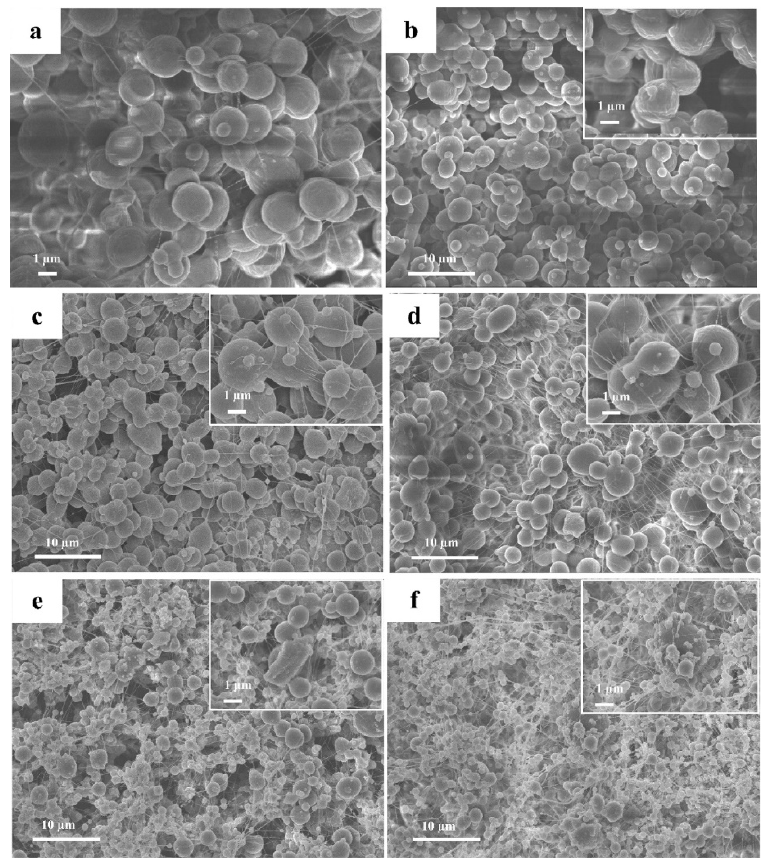
Figure 12. Morphology of the PCL/SiO 2 -the composites with different contents of SiO 2 aerogel: ( a ) PCL; ( b ) 0.1% SiO 2 aerogel; ( c ) 0.3% SiO 2 aerogel; ( d ) 0.5% SiO 2 aerogel; ( e ) 0.7%; and ( f ) 1.0% SiO 2 aerogel. Reprinted with permission from [36]. Copyright ©2021 American Chemical Society.